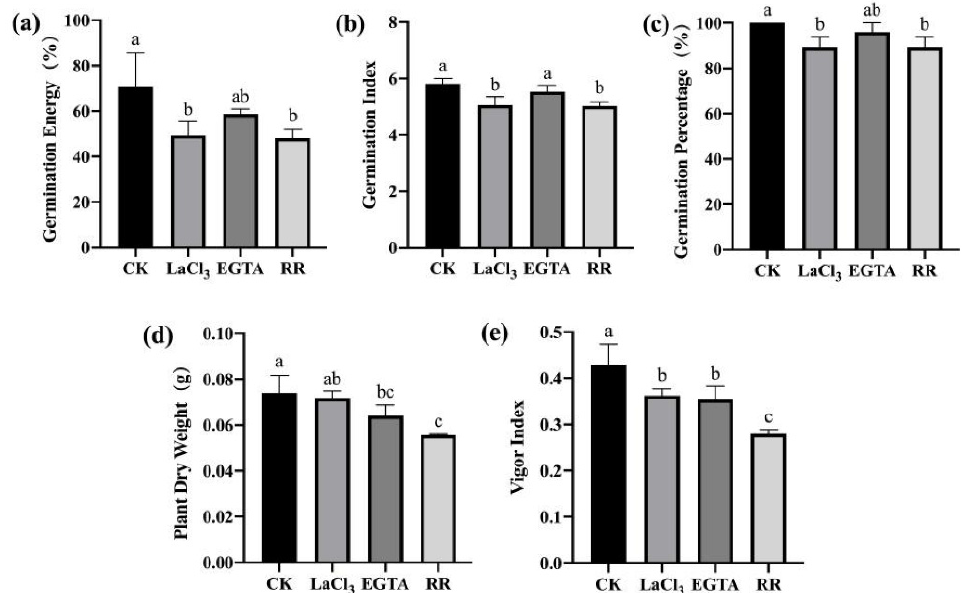
Figure 5. Ca 2+ chelating agent/channel inhibitor treatments reduced F. graminearum resistance in high-vigor maize seeds. ( a ) germination energy (%), ( b ) germination index, ( c ) germination percentage (%), ( d ) dry weight of single plant (g), ( e ) vigor index. EGTA, ethylene glycol-bis(beta-aminoethyl ether)- N -tetraacetic acid; RR, Ruthenium Red; CK, control. Different letters indicate significant differences among different lines (Tukey’s test).